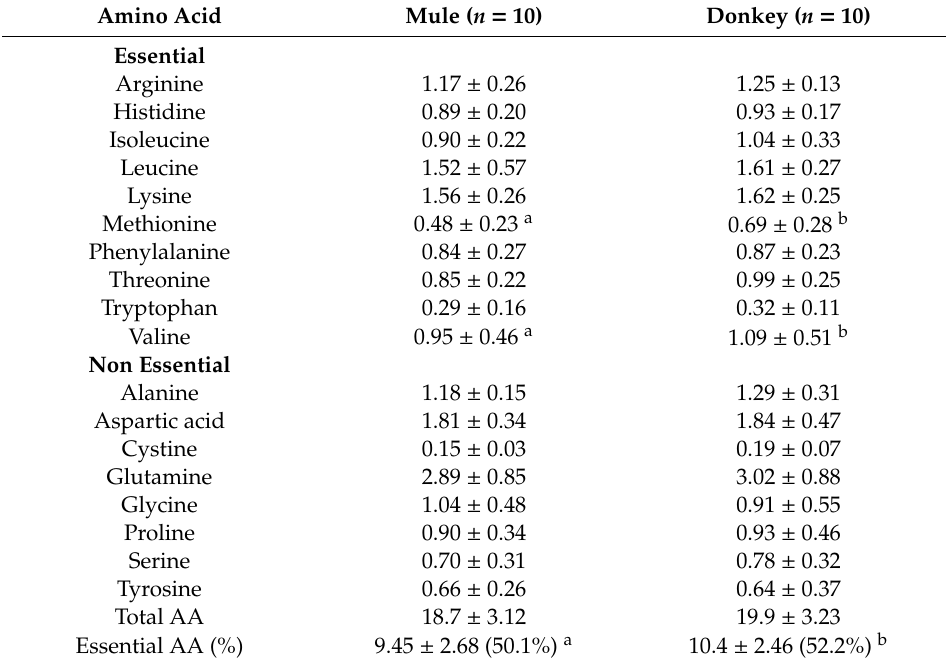
Table 5. Amino acid composition (g / 100 g muscle) of mule and donkey Longissimus thoracis muscle (means ±